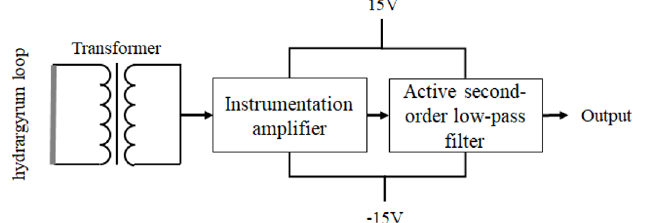
Fig. 6. Measuring circuit.